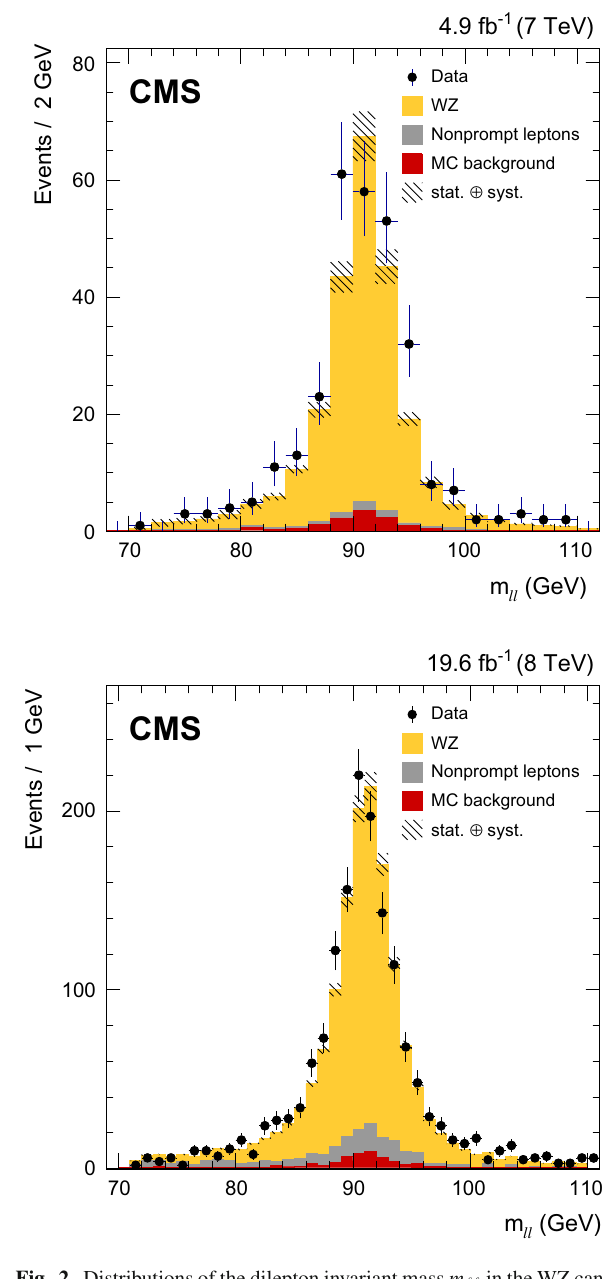
Fig. 2 Distributions of the dilepton invariant mass m (cid:5)(cid:5) in the WZ can- didate events in 7TeV ( top ) and 8TeV ( bottom ) data. Points represent data and the shaded histograms represent the WZ signal and the back- groundprocesses.Thecontributionfromnonpromptleptons,dominated by the tt and Z+jets production, is obtained from data control samples. Thecontributionfromallotherbackgrounds,labeled‘MCbackground’, as well as the signal contribution are determined from